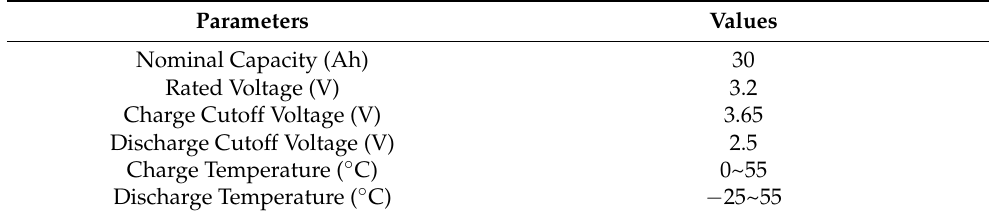
Table 1. Specifications of CB2P0 lithium-ion